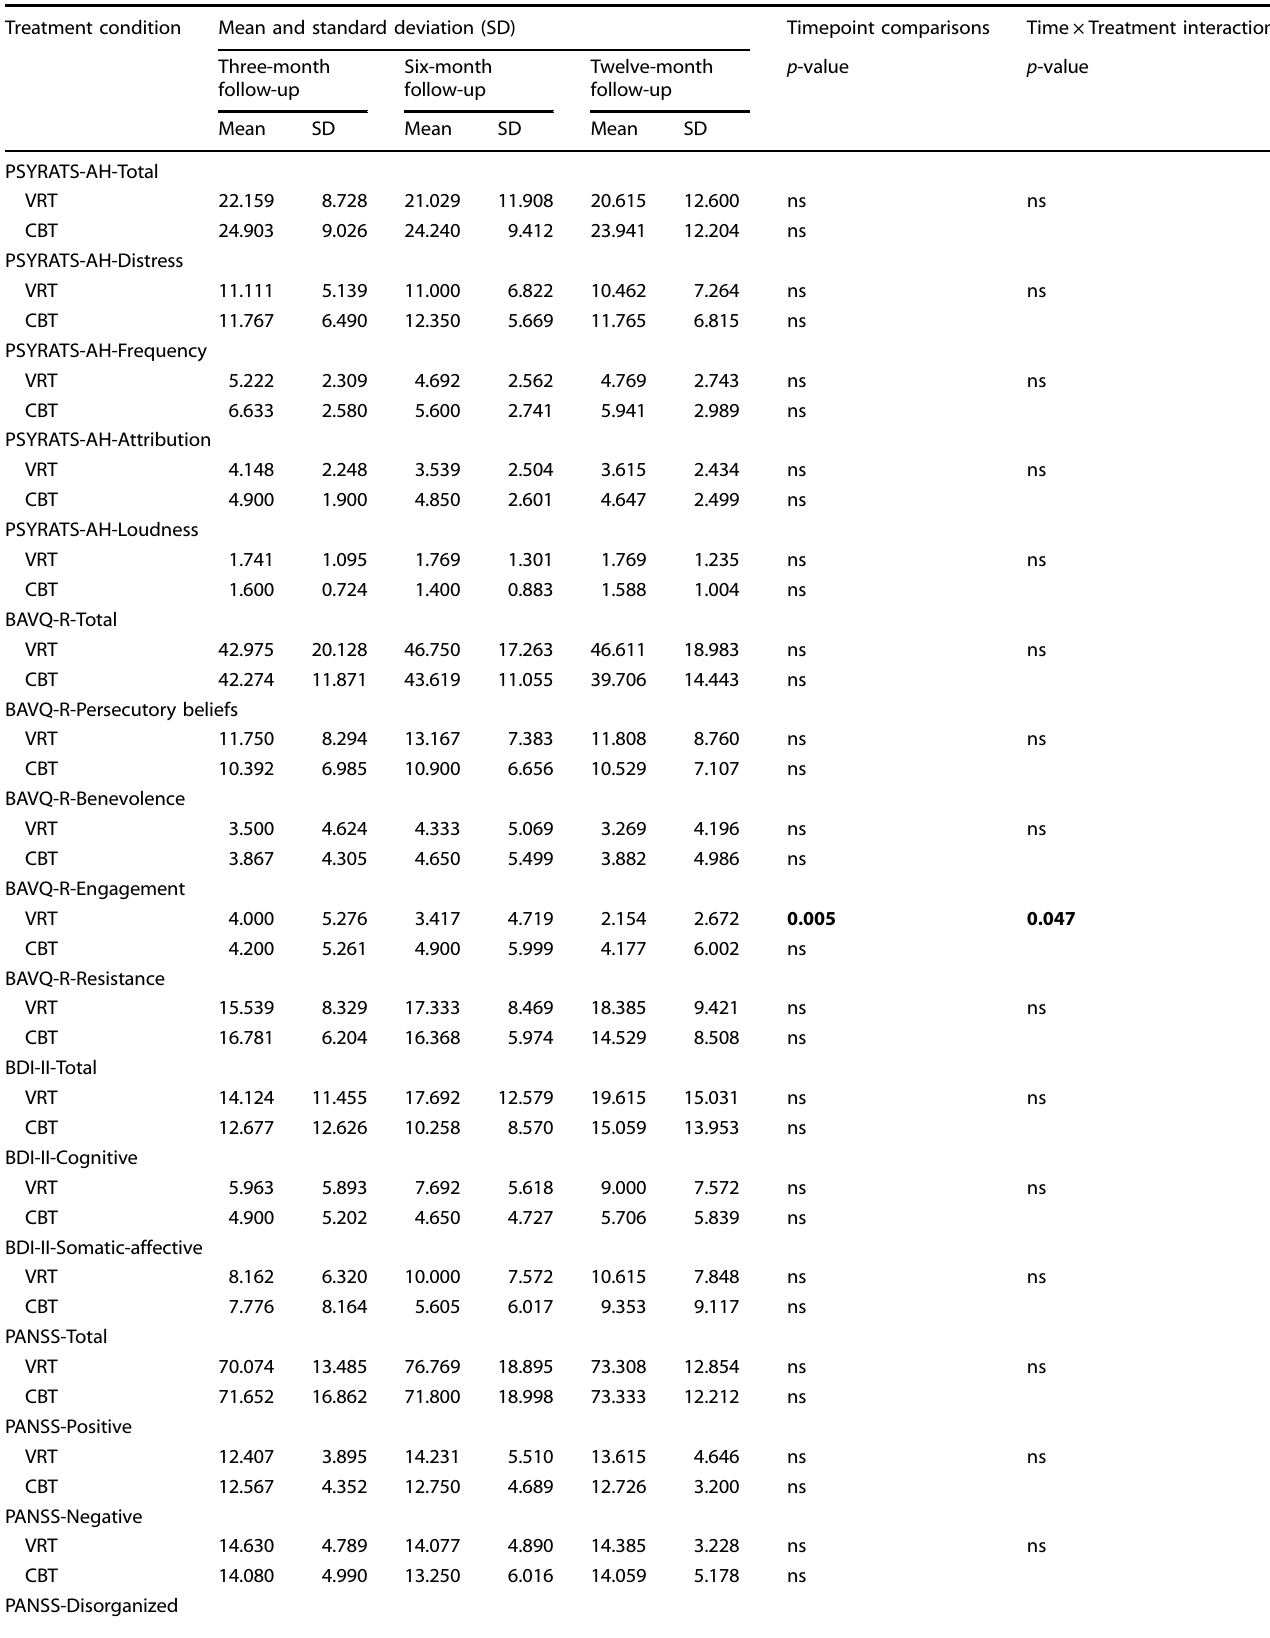
Table 3. Outcomes at 3-, 6-, and 12-month follow-up for long-term maintenance comparison. Treatment